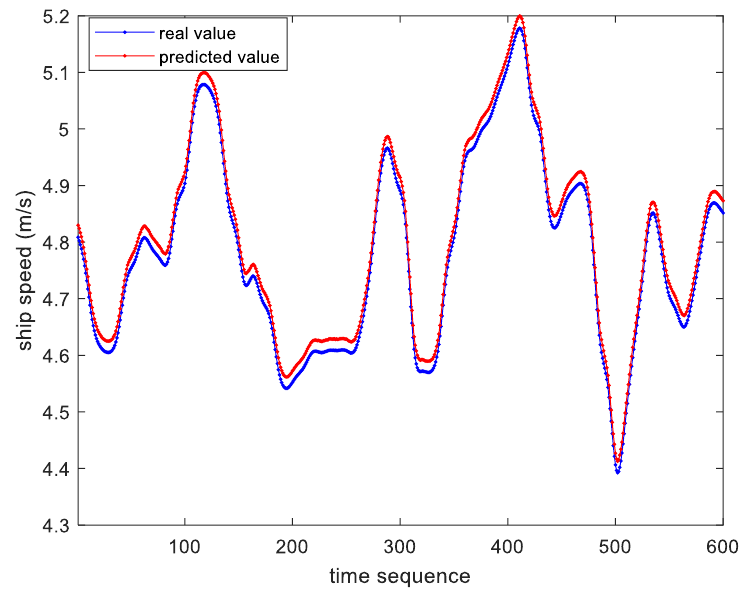
Figure 5. Prediction results of current speed.